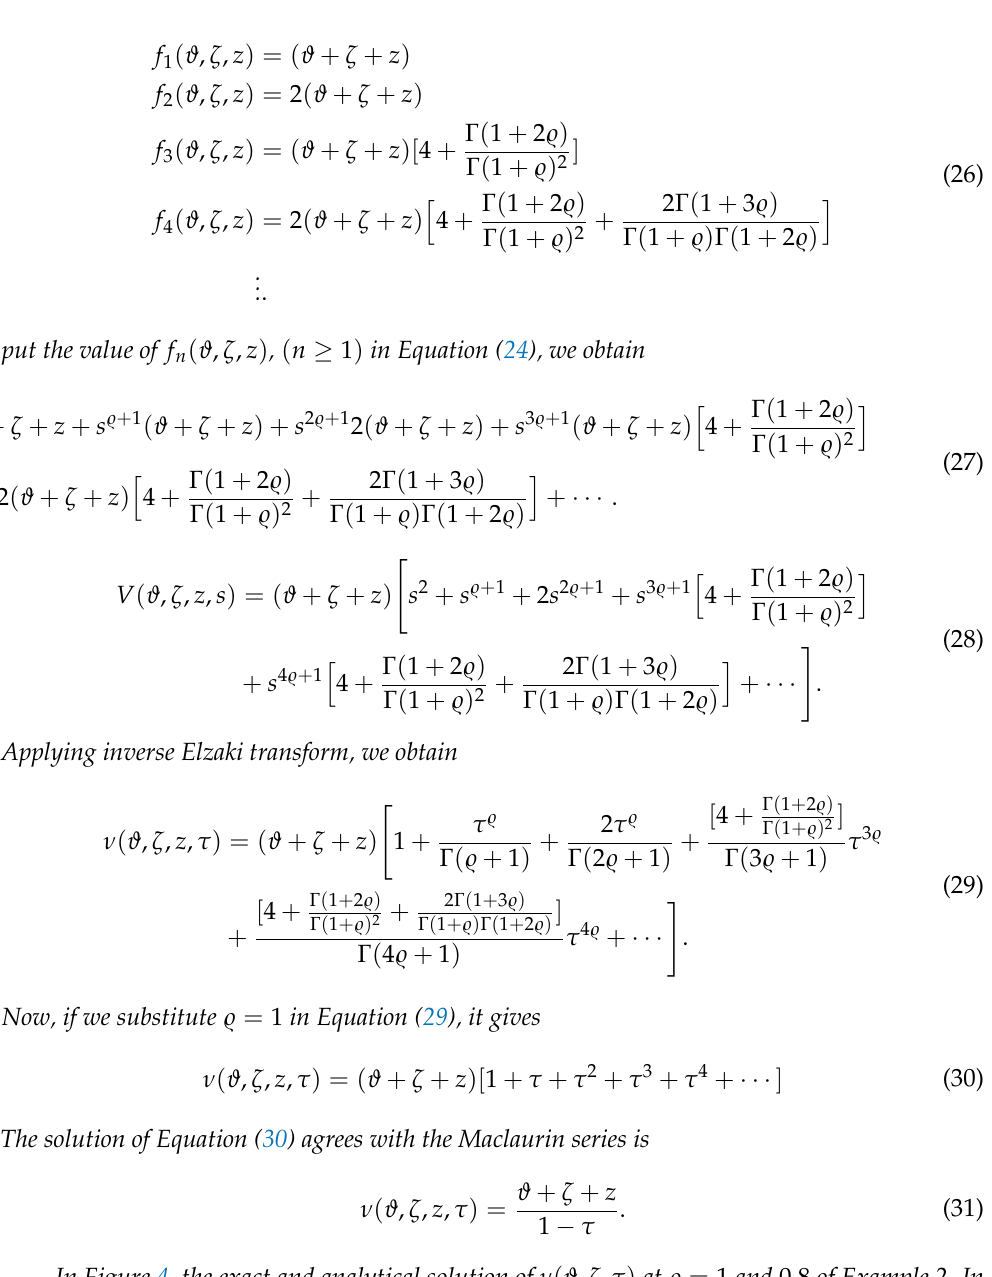
Figure 5, the analytical solutions of ν ( ϑ , ζ , τ ) at (cid:36) = 0.6 and 0.4 and similarly in Figure 6, the different fractional order of (cid:36) of ν ( ϑ , ζ , τ ) of Example 2, which show that the close contact with the exact